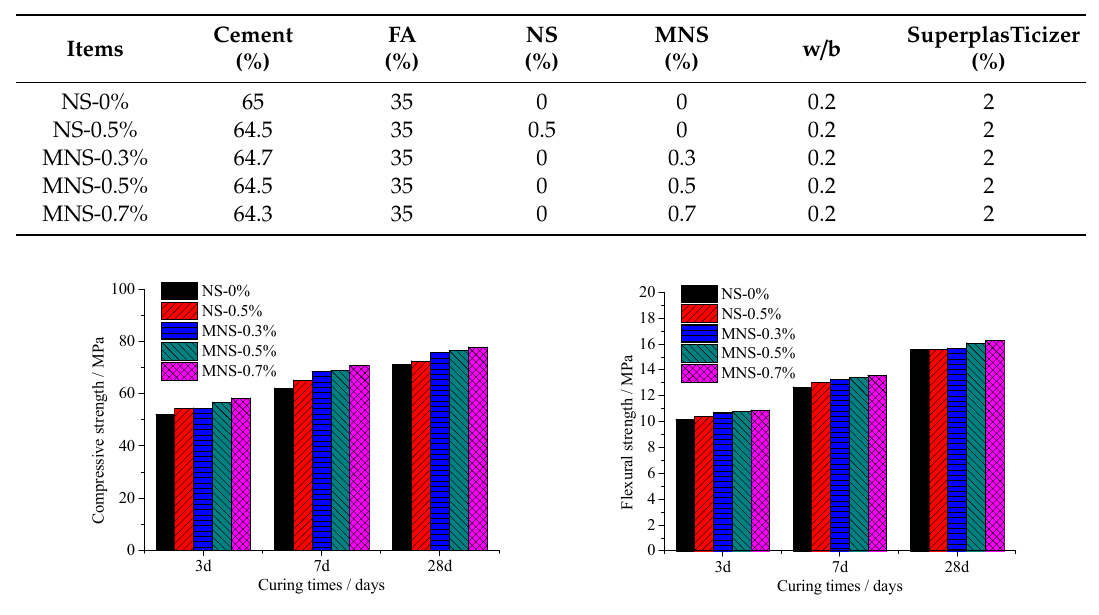
Table 4. Mix proportions of HPC.